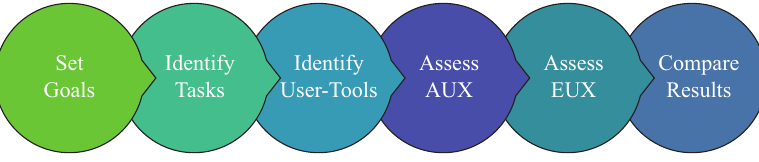
Figure 2. Steps of the Anticipated User eXperience (AUX) and Episodic UX (EUX) assessment